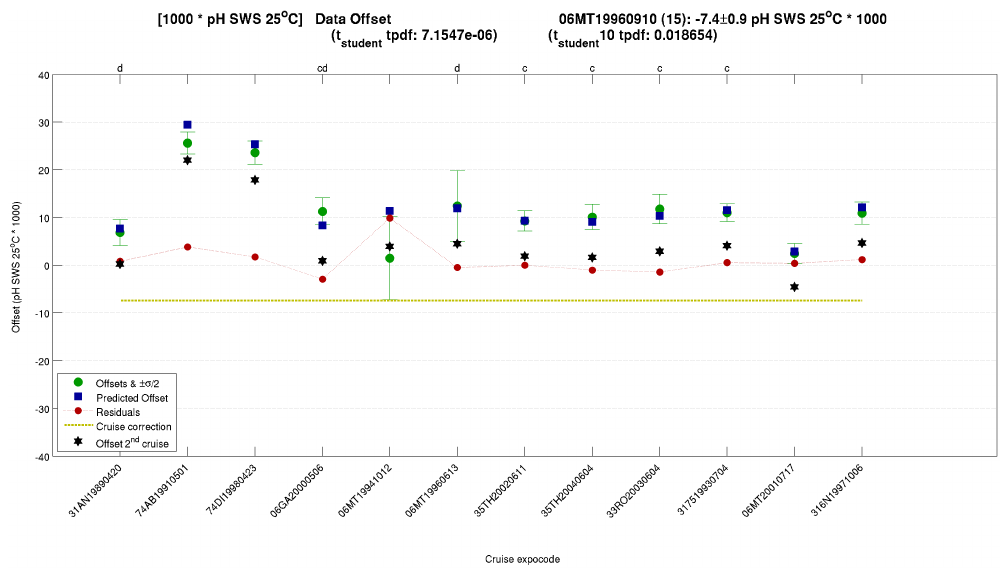
Figure 5. Cruise crossover information plot for 06MT19960910